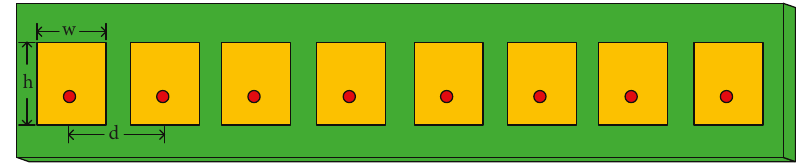
Figure 3: Geometry of the eight-element linear patch antenna array.